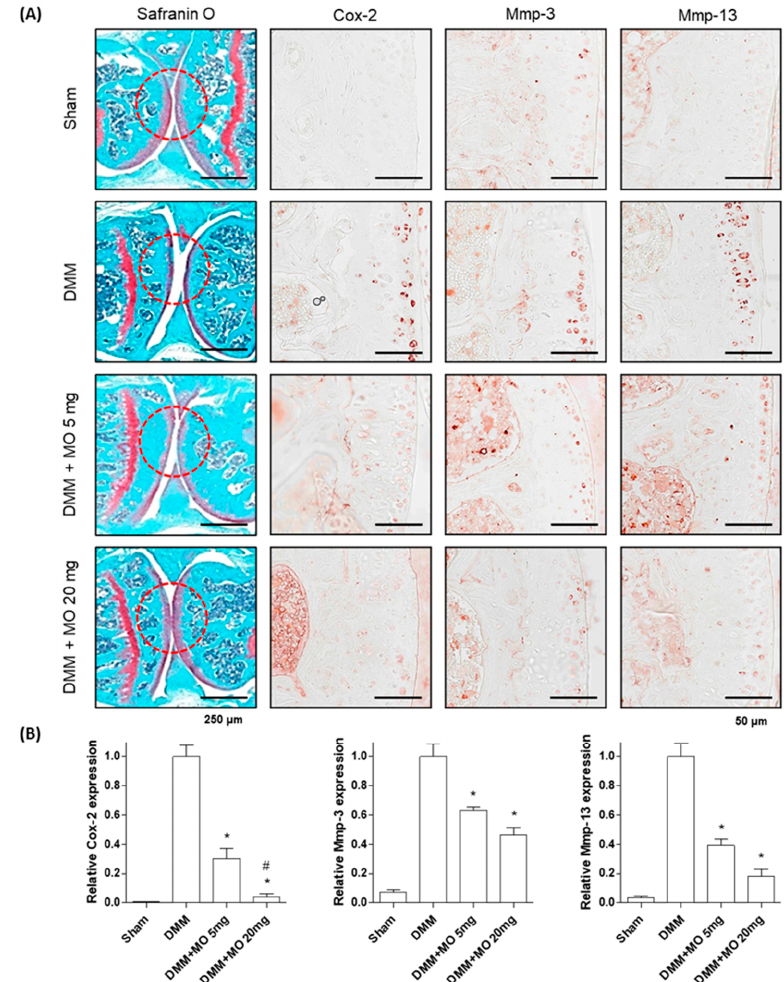
Figure 5. Effects of morroniside on DMM-induced OA pathogenesis in mice. Mice were treated with morroniside (5 and 20 mg/kg/day) for 10 weeks. ( A ) Articular cartilage sections were stained with safranin O and IHC for Cox-2, Mmp-3, and Mmp-13 was performed. Representative images were visualized by light microscopy. Red circle indicates the degeneration of the articular carti- lage. ( B ) IHC images were quantified and determined using one-way ANOVA (Tukey’s honest significant difference post hoc test, analysis of variance). * p < 0.05 vs. DMM. # p < 0.05 vs. DMM+MO 5 mg. DMM, destabilization of the medial meniscus; OA, osteoarthritis; IHC, immuno- histochemistry; Sham; sham-operated, MO; morroniside; Cox-2, cyclooxygenase-2; MMP-3, metal- loproteinase 3; MMP-13, metalloproteinase 13. Scale bars: 50–250 μ m.